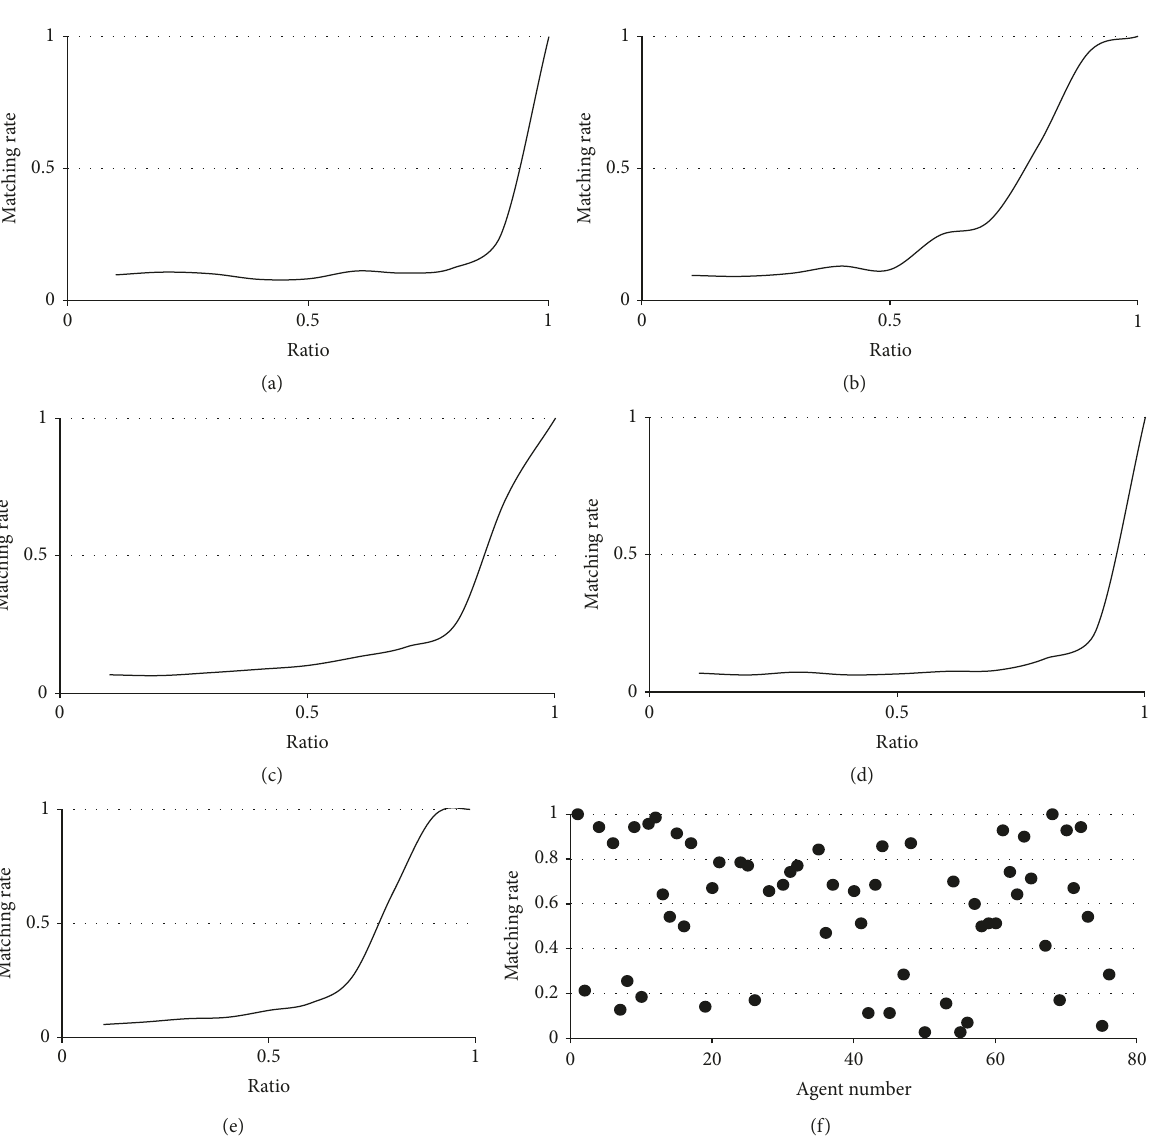
Figure 2: Matching rate of successive two trials regarding ratio (asymmetric TSP). (a) Data from eil51. (b) Data from berlin52. (c) Data from st70. (d) Data from eil76. (e) Data from pr76. (f) An example of matching rate distributions for each agent (data from pr76 are shown). The smaller the ratio is, the more frequently the agent chooses the furthest site. Matching rate becomes worse at that